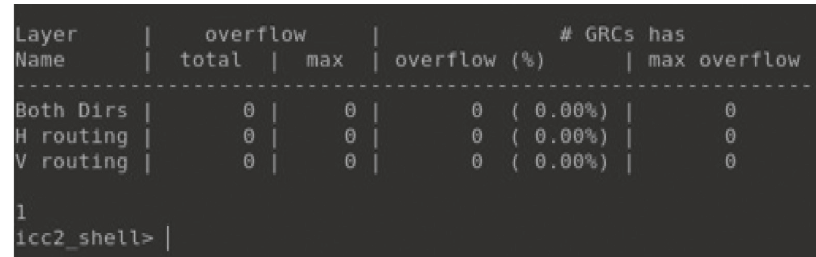
Figure 3: Initial part of the simulation report for the optimized benchmark.